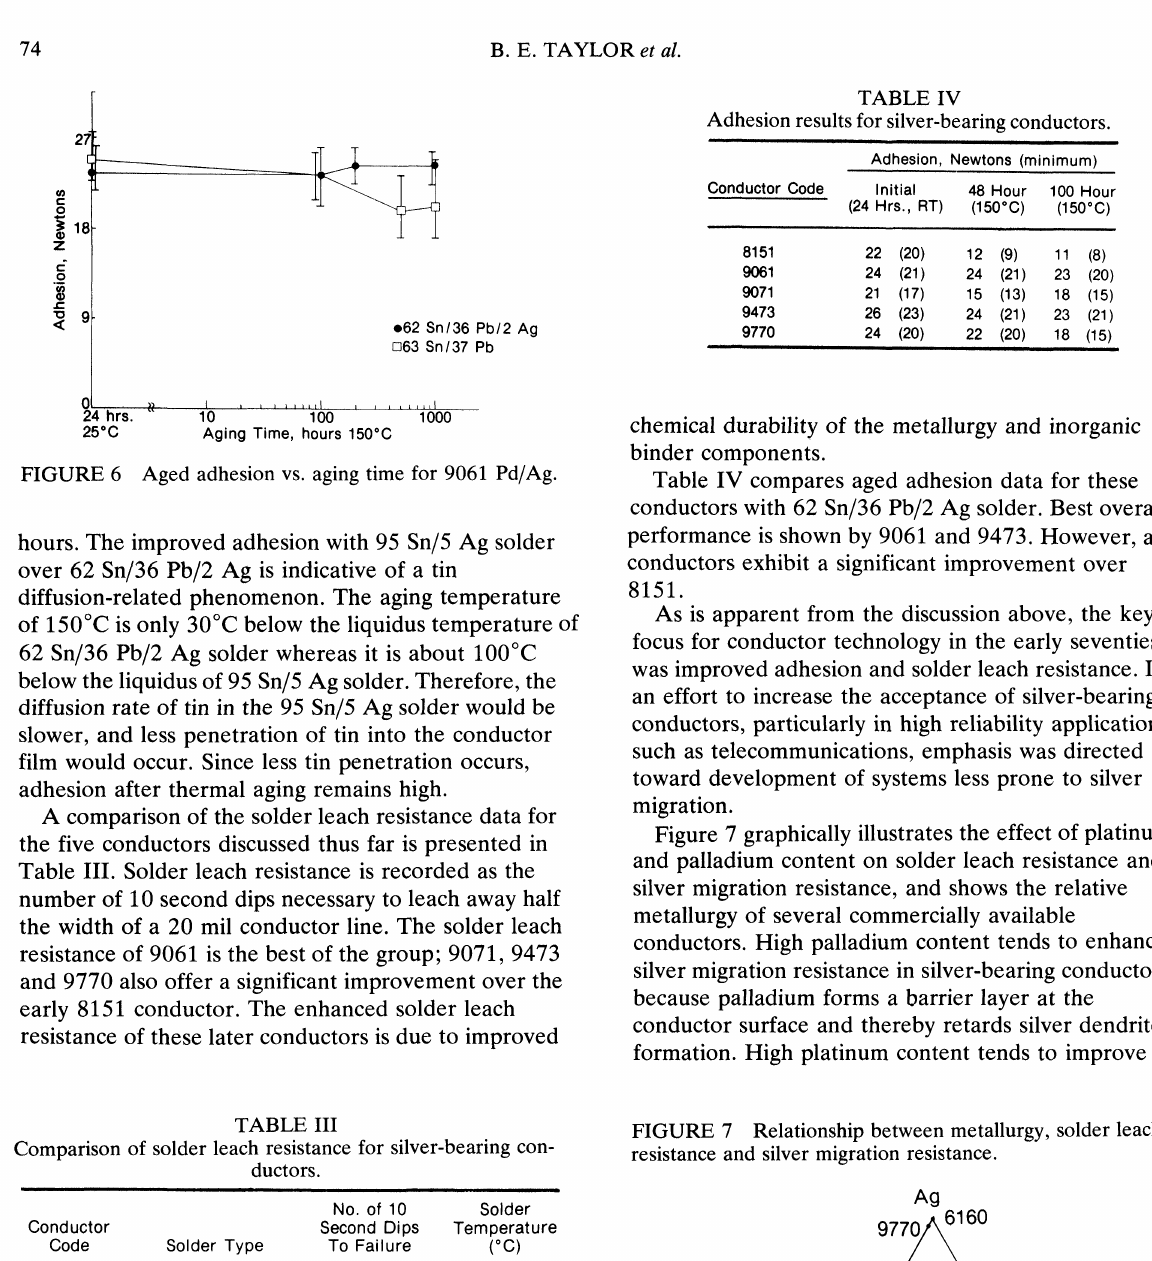
Comparison of solder leach resistance for silver-bearing con- ductors.